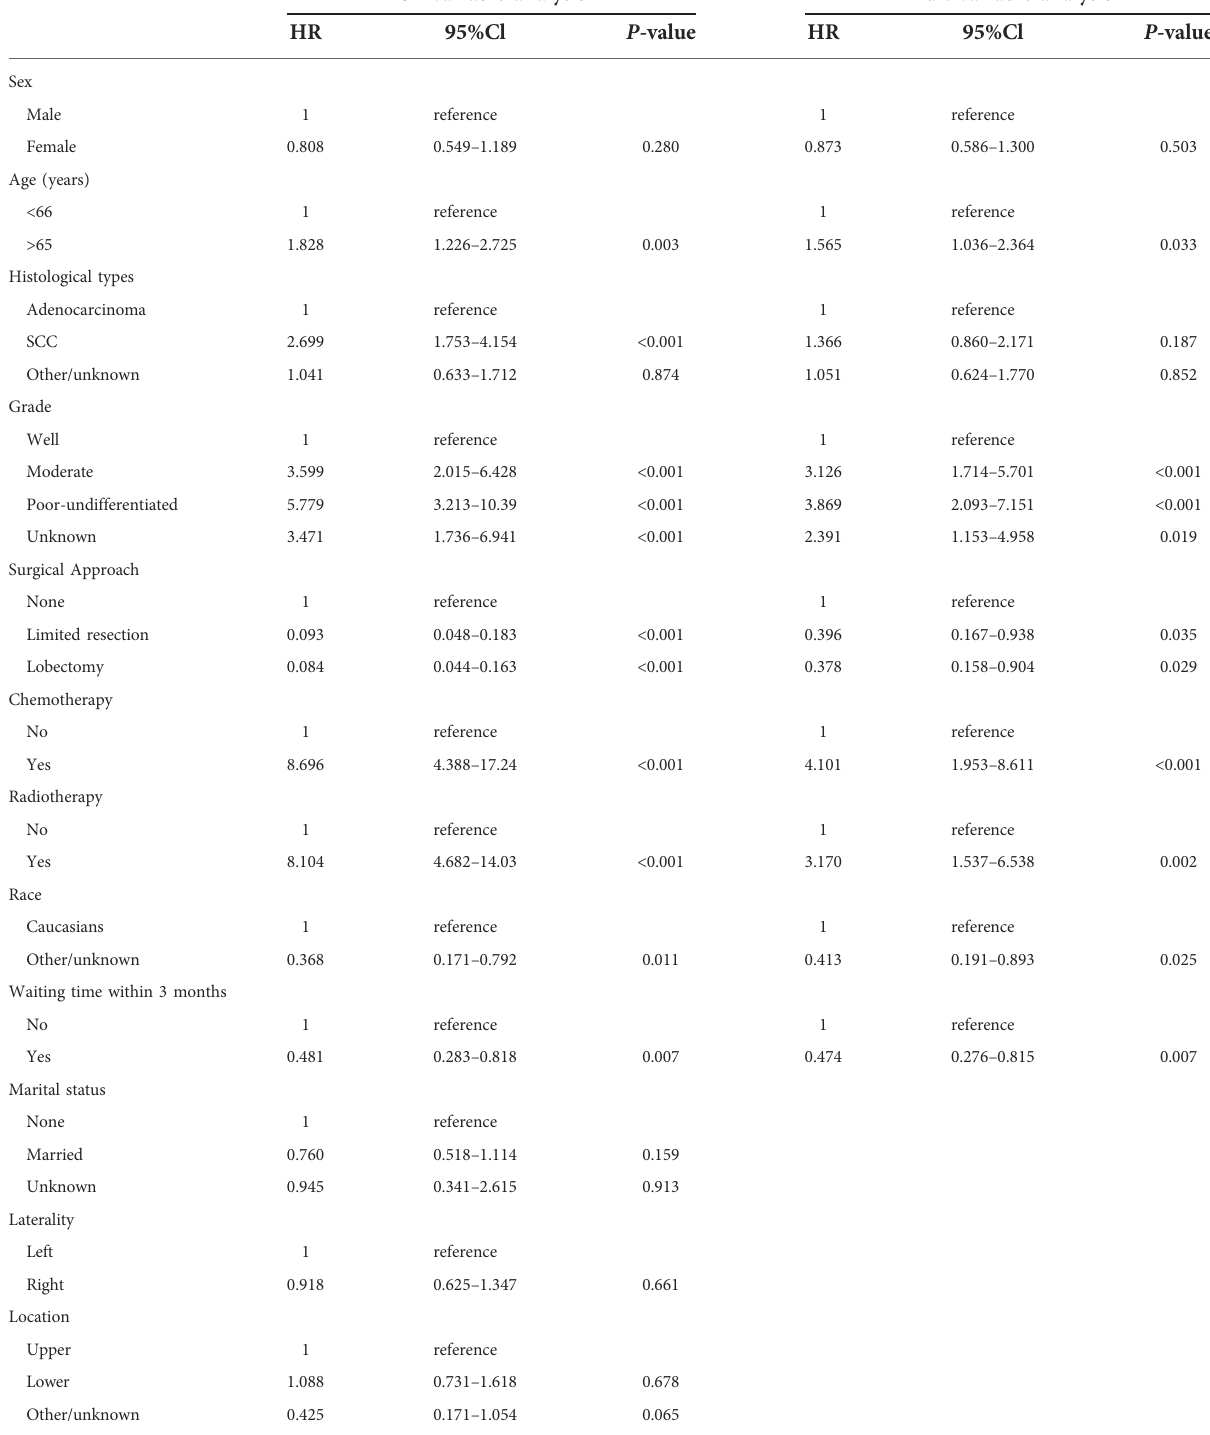
TABLE 3 The univariable and multivariable Cox regression analyses for patients ’ cancer-speci fi c